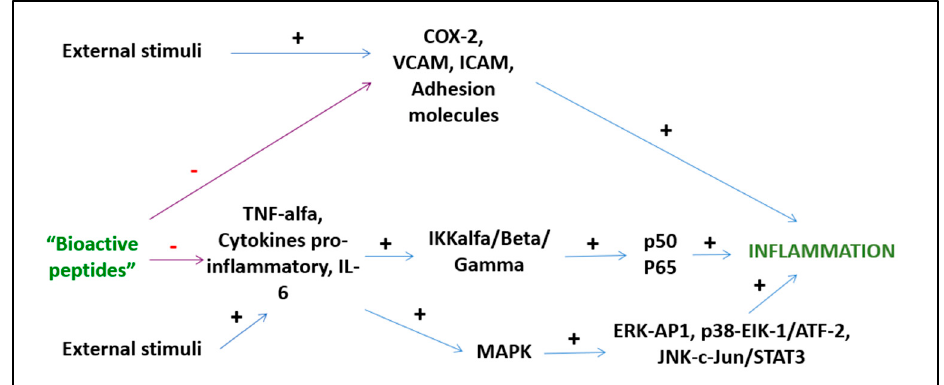
Figure 3. Anti-inflammatory activities of BPs